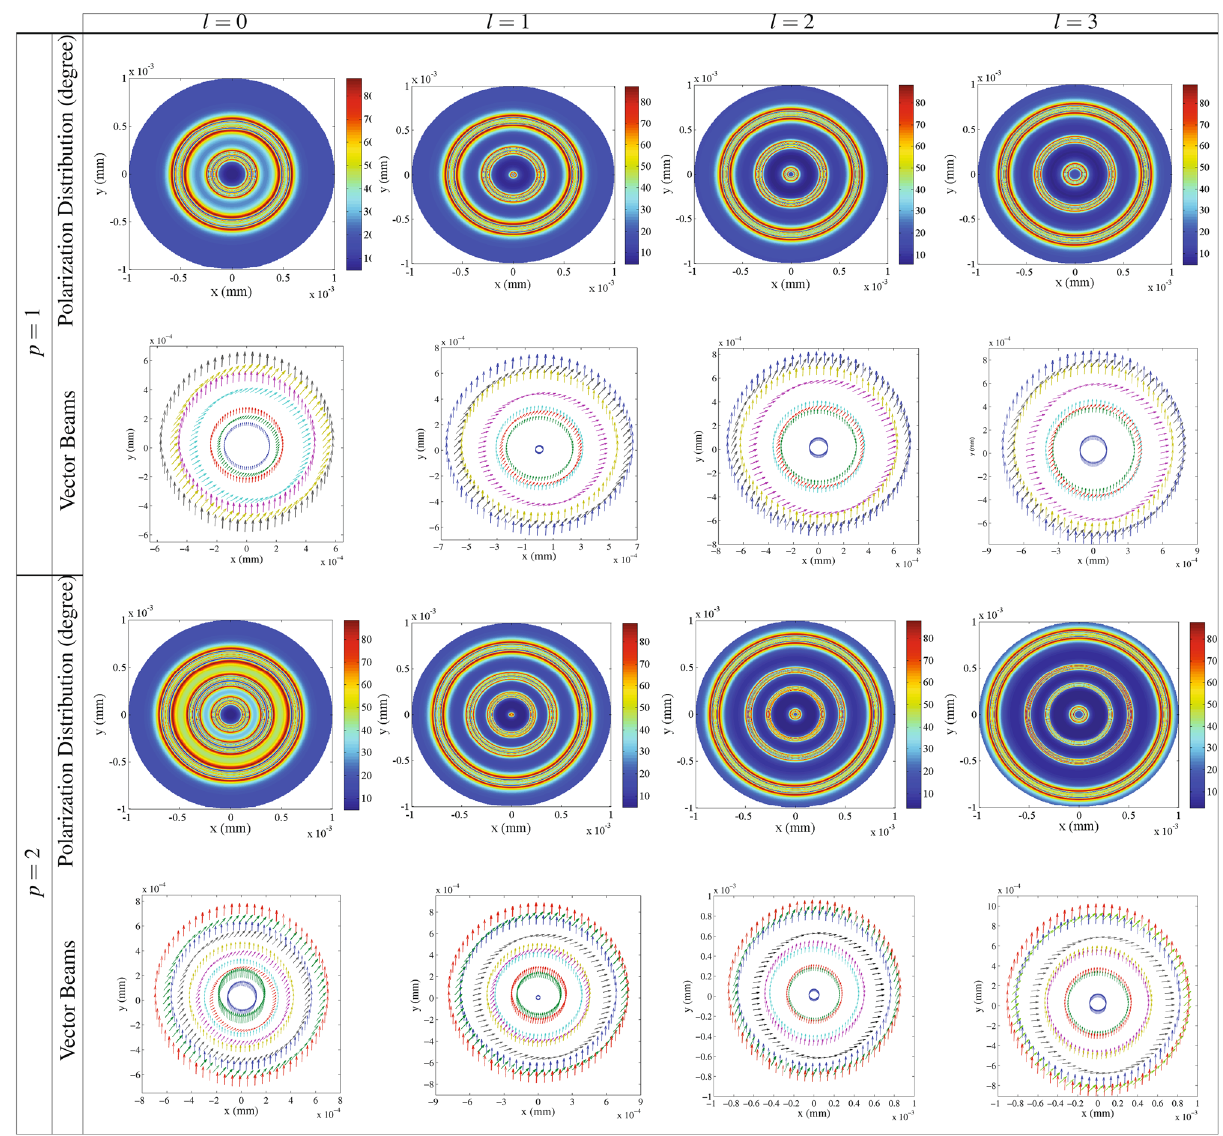
Figure 6. Polarization distribution of the transmitted probe field (first and third rows) in unit of degree and a schematic of the generated VB (second and fourth rows) as a function of x and y for Gaussian field l different modes of LG control field l The other parameters are those used in Fig.